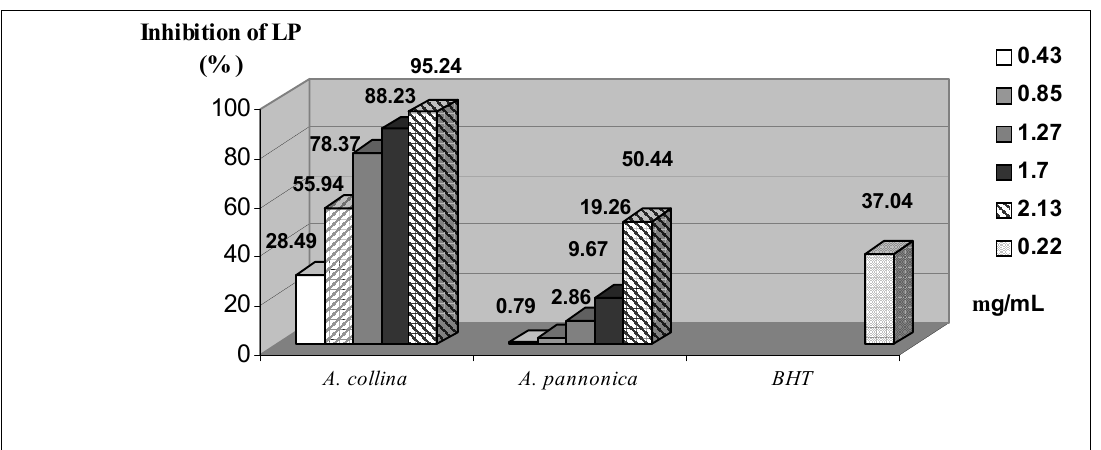
Figure 1 . Inhibition of lipid peroxidation (LP) in Fe 2+ /ascorbate system of induction by investigated essential oils and BHT (as a positive control) a in the TBA assay. Concentrations labeled in the legend are expressed in